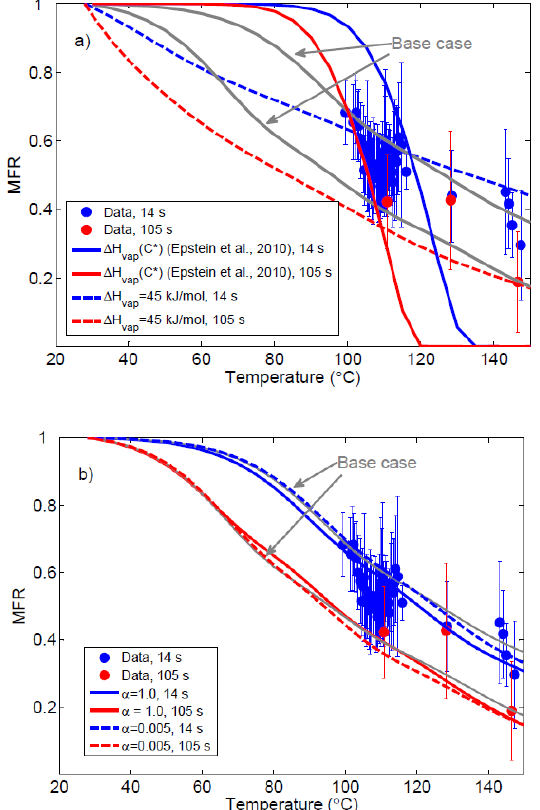
Figure 9. The modeled mass fractions remaining (lines, see Table 1 for details) Fig. 9. The modeled mass fractions remaining (lines, see Table 1 for corresponding to different input data to the TD model, along with the fitting data set details) corresponding to different input data to the TD model, along (markers). Each data point is the average of 30 MFR data sets (each MFR data set is 24 min with the fitting data set (markers). Each data point is the average of averaged). The sensitivity runs with a) low vaporization enthalpy and vaporization enthalpy 30 MFR data sets (each MFR data set is 24min averaged). The sensitivity runs with (a) low vaporization enthalpy and vaporization of Epstein et al (2010), b) unity mass accommodation coefficient and mass accommodation enthalpy of Epstein et al. (2010), (b) unity mass accommodation coefficient of 0.005. The blue color corresponds to residence time of 14 s, and the red to 105 coefficient and mass accommodation coefficient of 0.005. The blue s. color corresponds to residence time of 14s, and the red to